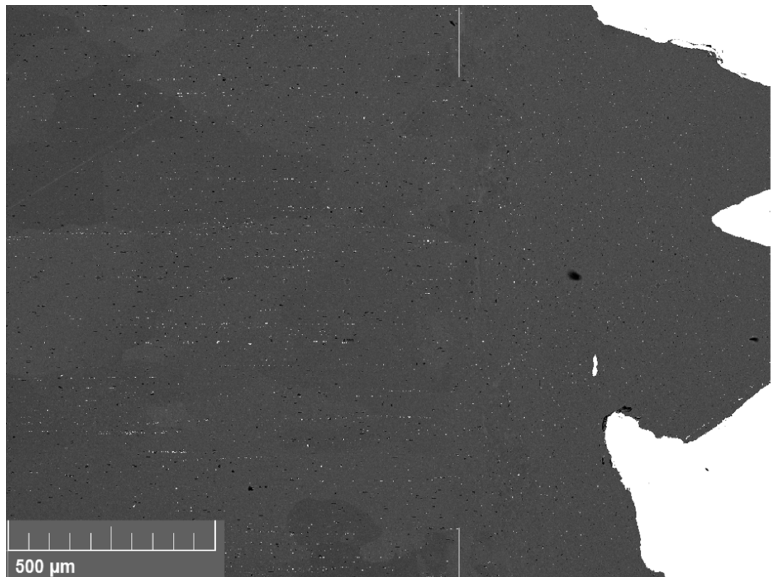
Figure 4. SEM micrograph taken in BSE mode with vertical lines added to show the boundary of the stir zone adjacent to the tool. Note: The bright particle observed above and to the left of the thread tip was determined to be a fractured piece of the tool.